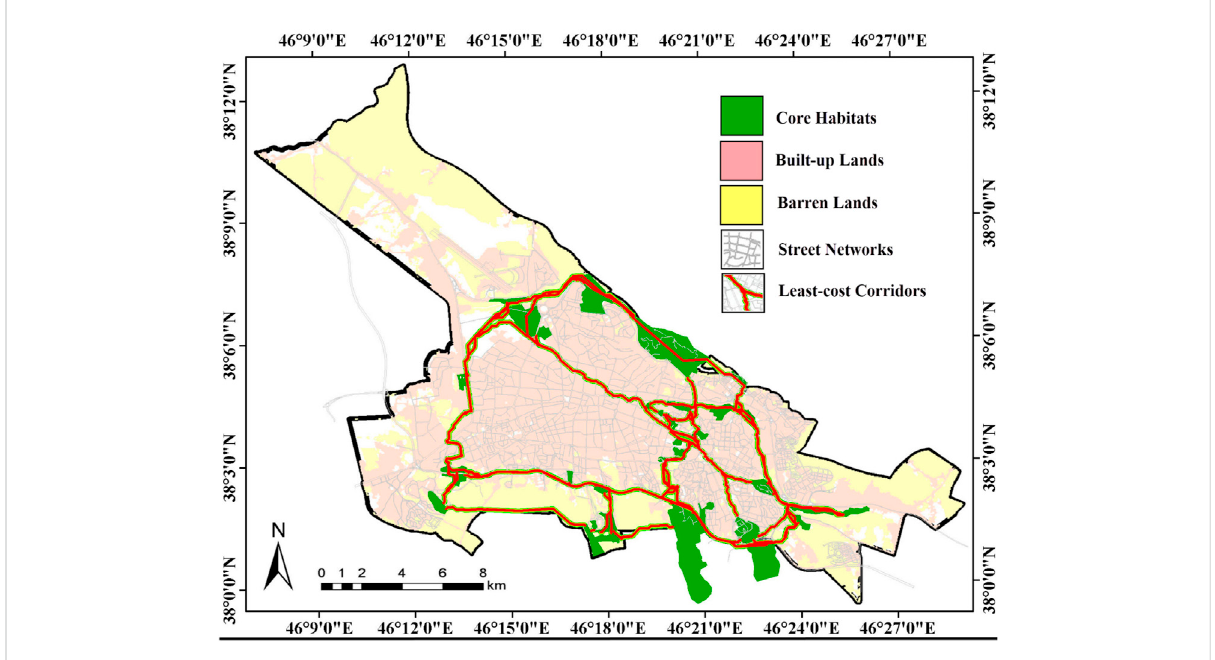
FIGURE 7 Least-cost corridors between core patches in the city of Tabriz (these corridors are the least-cost corridors between core patches based on Figure 6 and the higher-cost corridors were